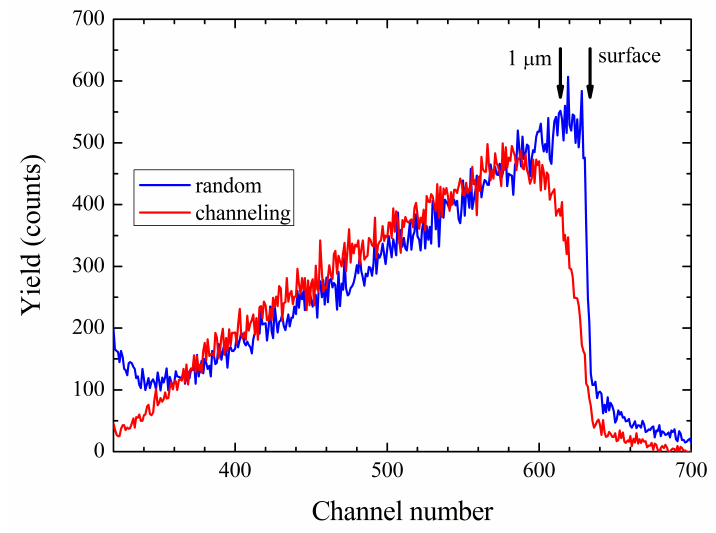
02¯21 - (cid:104) (cid:105) 02¯21 -axis) and ⟨ ⟩